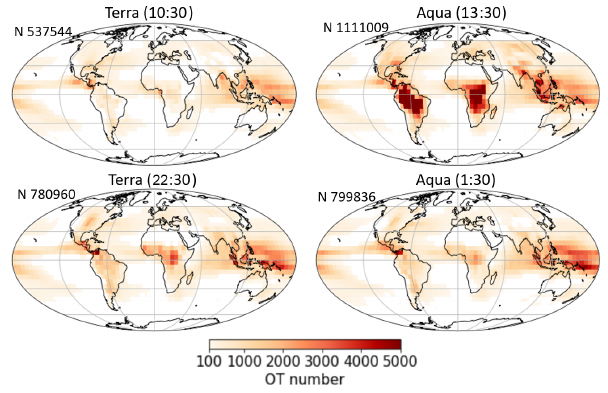
Figure 9. The global distributions of OTs at four observation times. Grids with the OT number < 100 are shown in white. N stands for sample